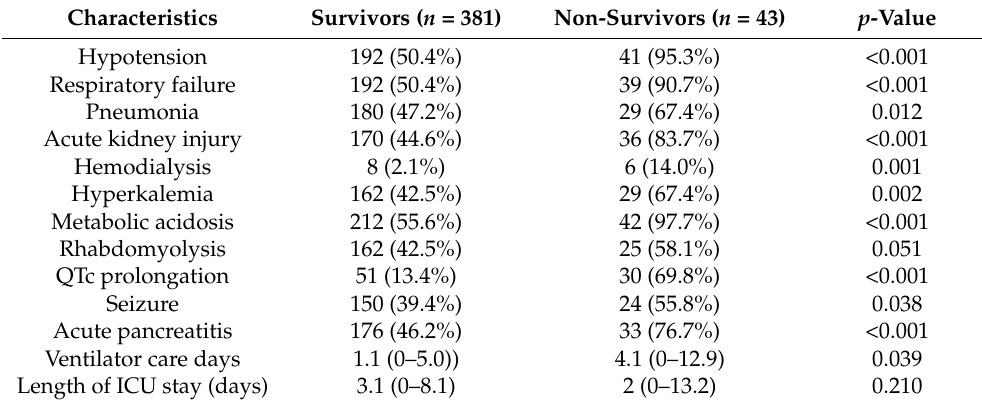
Table 2. Complications of glyphosate-poisoned patients with in-hospital